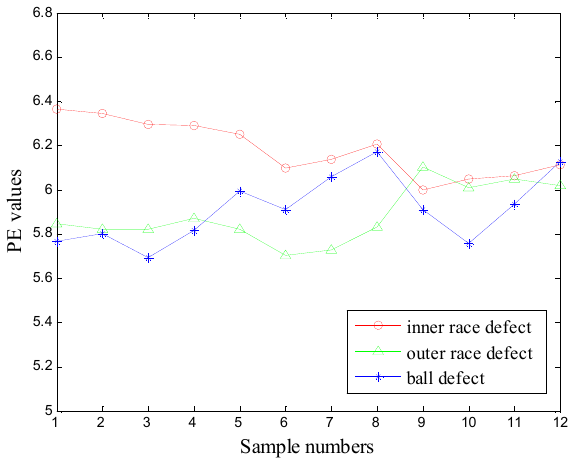
Figure 27. The permutation entropies of original signals.